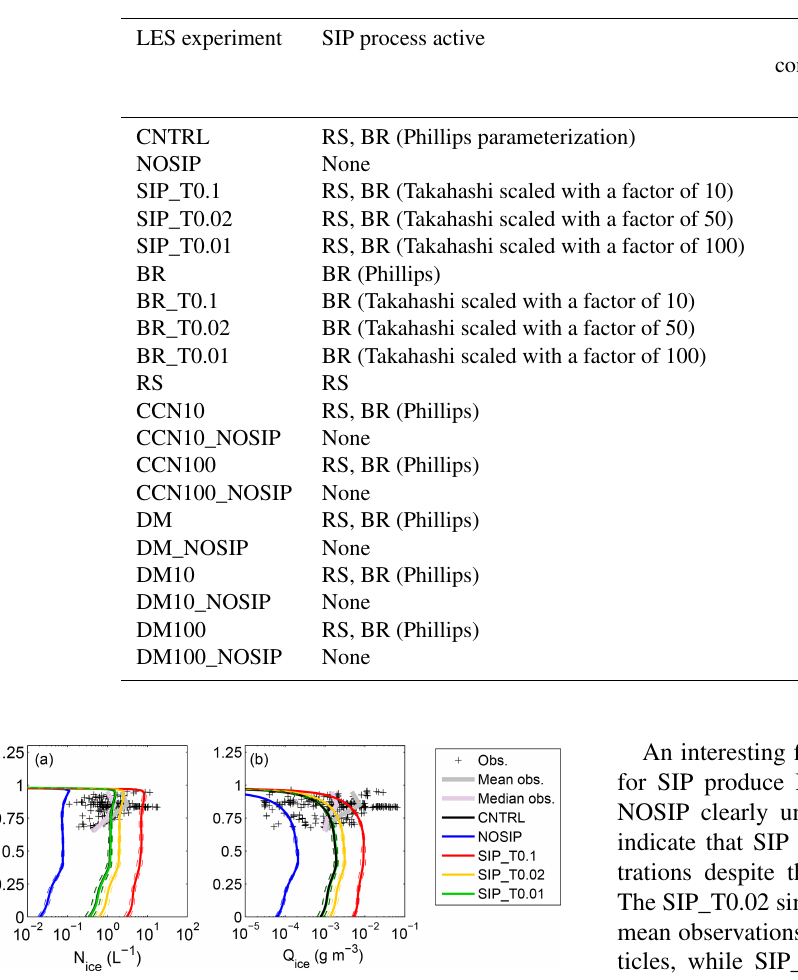
Table 1. Description of the LES experiments performed in this study.